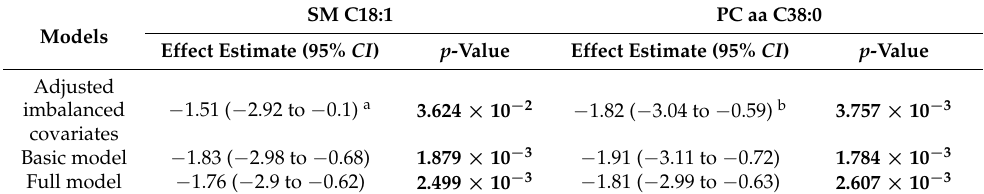
a with adjustments for sex, systolic blood pressure, total cholesterol, smoking status, and use of antihypertensive medication; b with adjustments for age, HDL cholesterol, and smoking